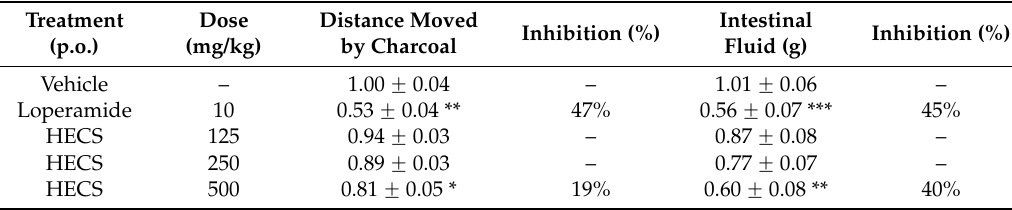
Table 3. Effect of the hydroalcoholic extract of Cissus sicyoides (HECS) on castor oil-induced intestinal fluid accumulation and transit.